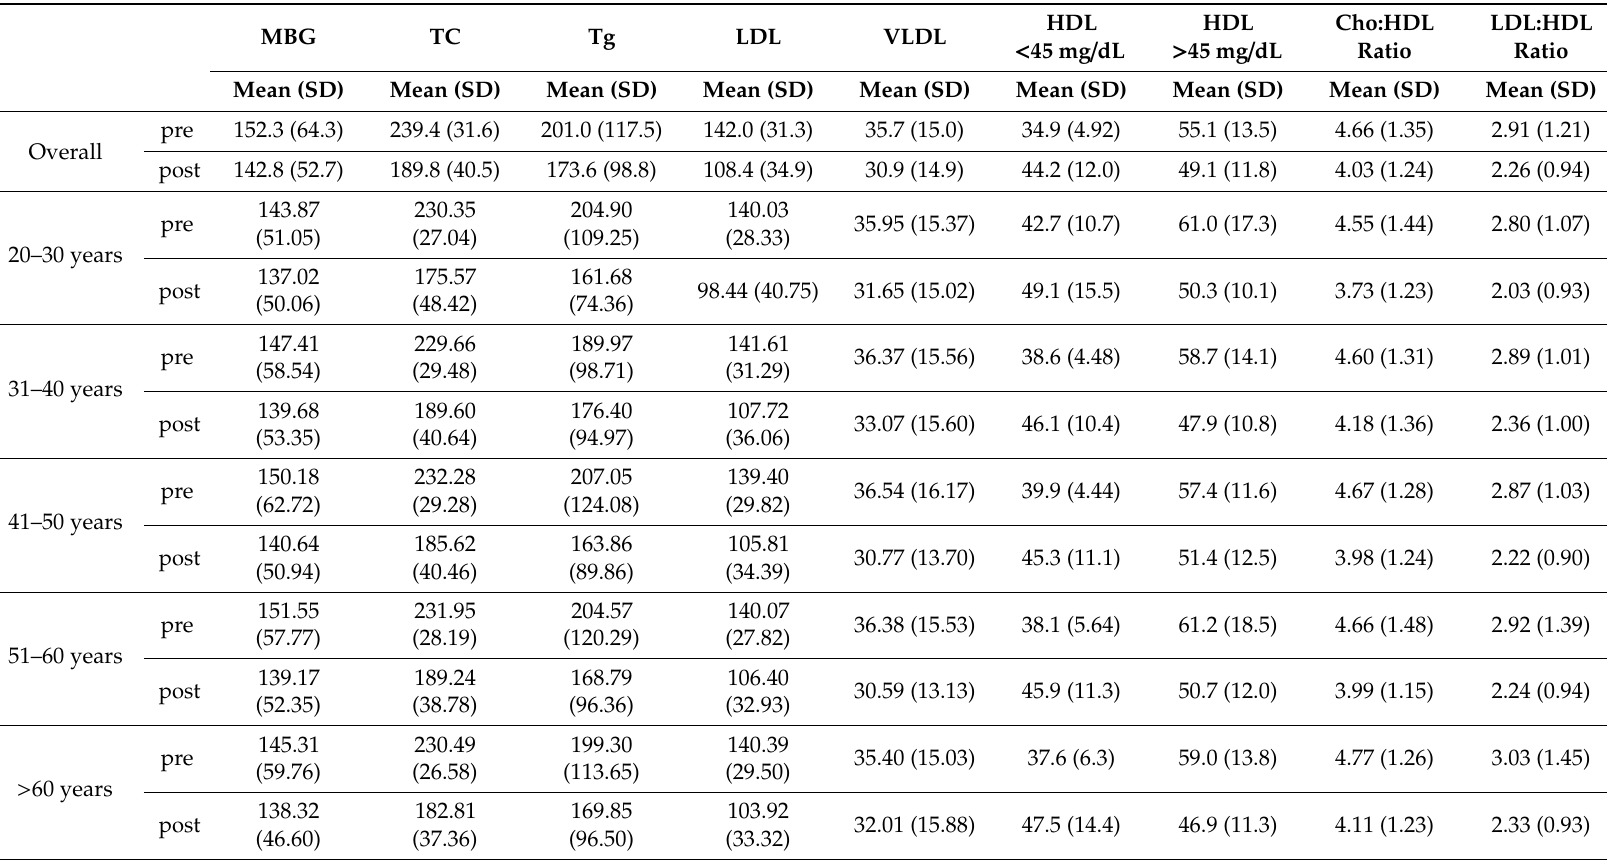
Table 1. Pre post changes in lipids in those with high Total Cholesterol in type 2 diabetes patients in di ff erent age